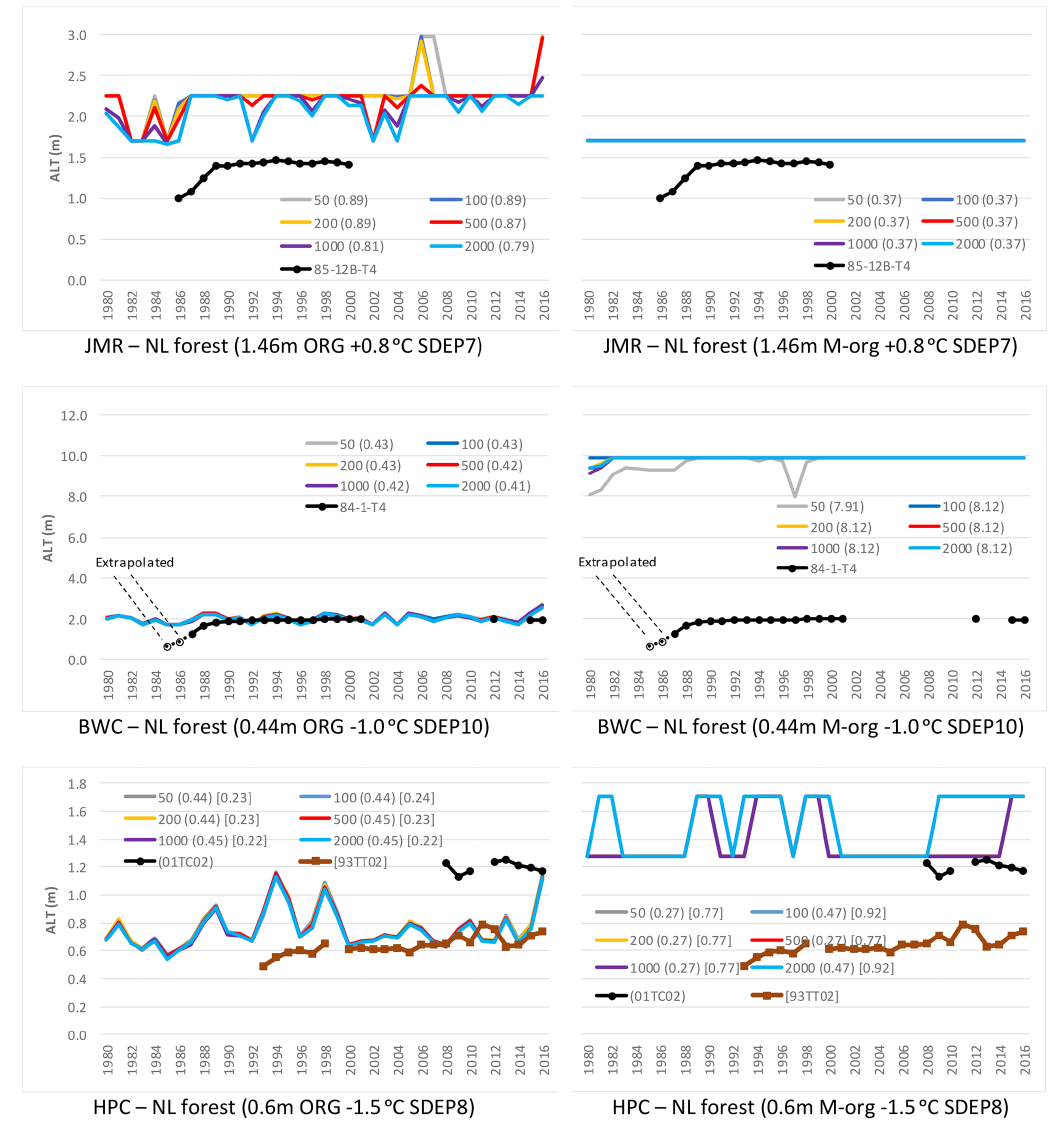
Figure 8. Impact of the number of spin-up cycles on the simulated ALT for the needleleaf forest GRU at all sites. Two organic configurations were used for each site using the SC2 layering scheme; RMSE is shown in